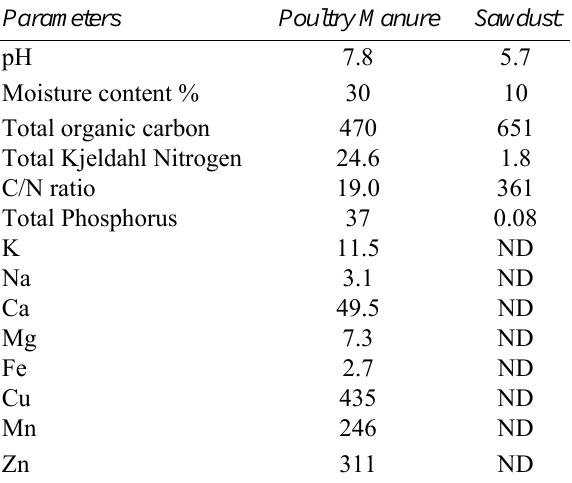
Table 2: Characteristics of amendments used